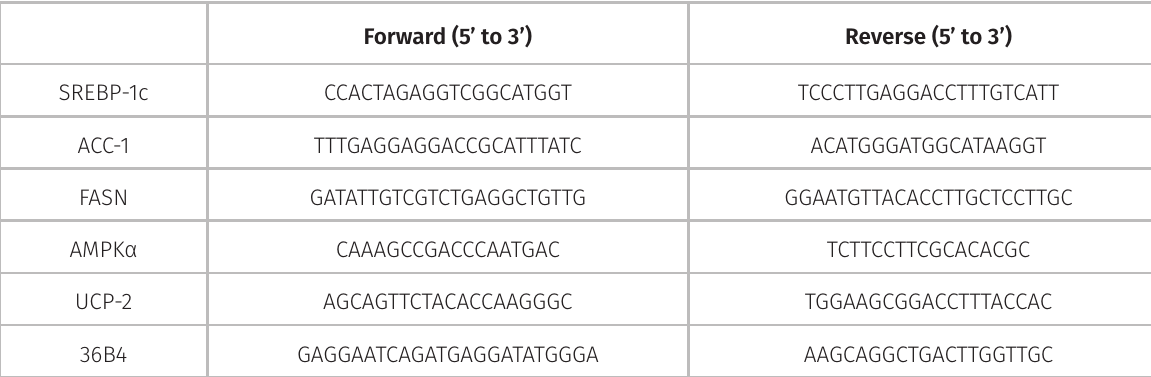
Table I. Primer sequences for genes involved in lipid metabolism in the